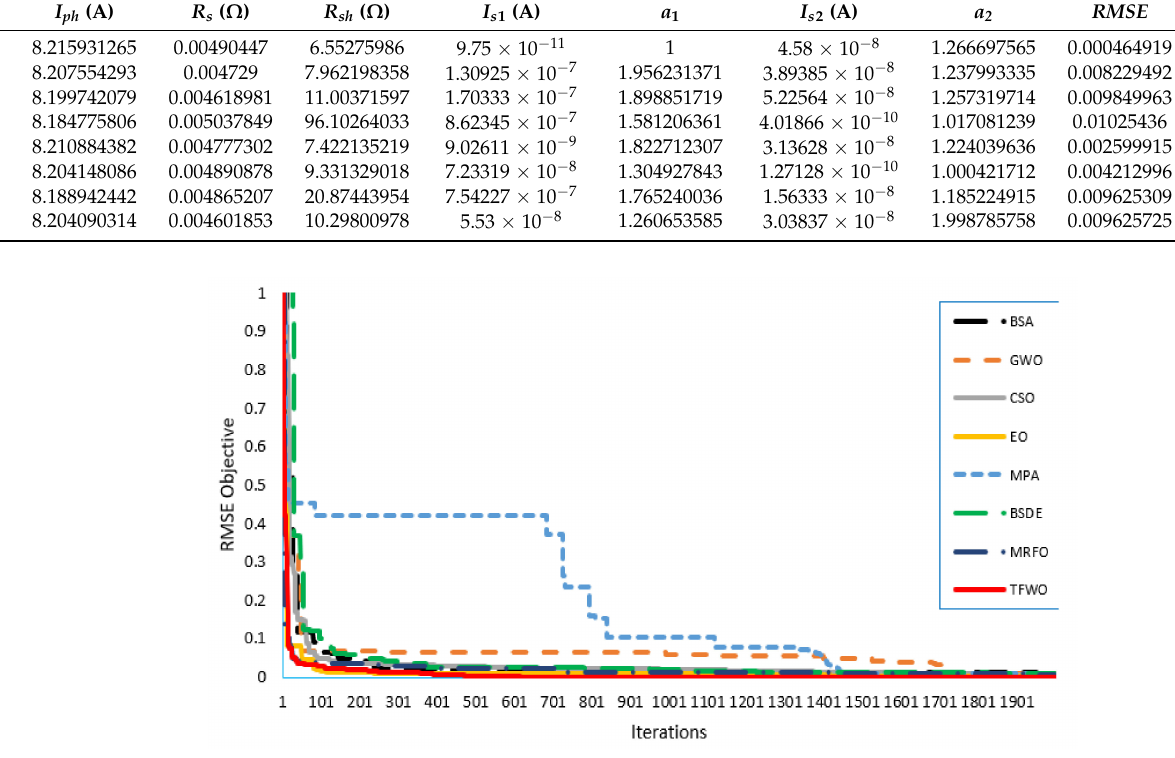
Figure 19. The convergence curves for KC200GT